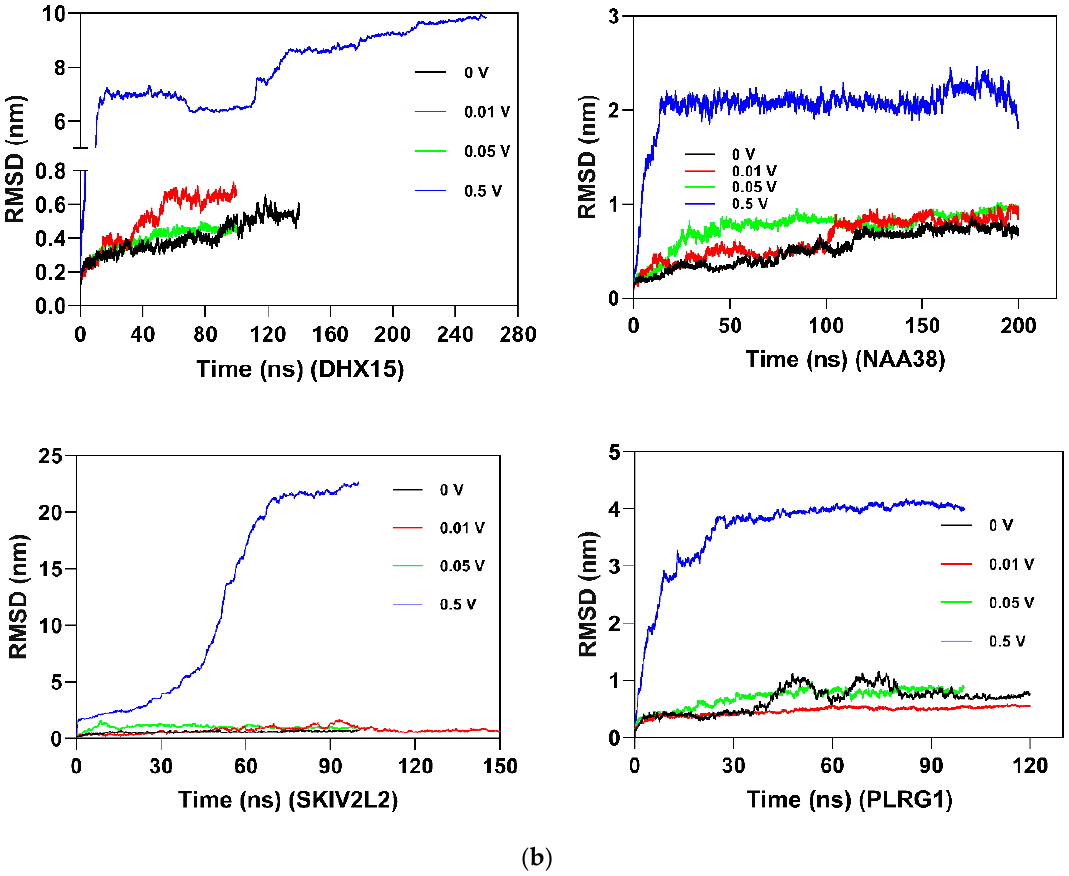
Figure 6. Root mean square deviation (RMSD) comparison plots of backbone C α atoms during molecular dynamics simulation (at least >100 ns). In order to show the deviations of hub proteins clearly, the RMSD plots are shown. ( a ) The RMSD of each hub protein under molecular dynamics (MD) of “protein in water”. ( b ) The RMSD of selected hub proteins under MD of “protein under nsPEFs”. For each protein, 0 V (black), 0.01 V (red), 0.05 V (green), and 0.5 V (blue) are displayed on one map.